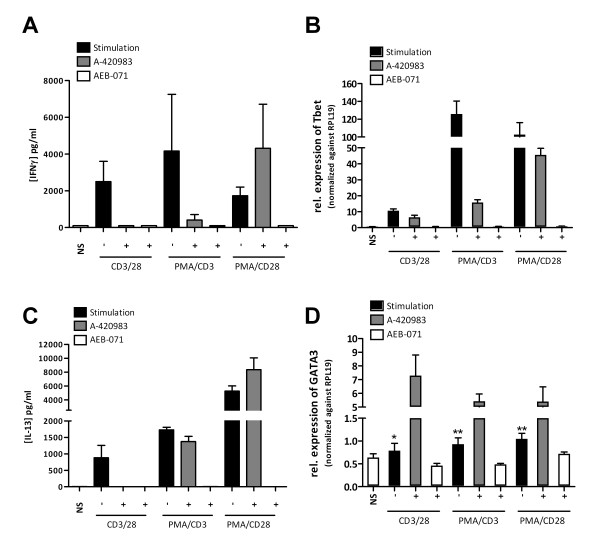
PMA/CD3 and PMA/CD28 effects on purified primary human CD4+ T cells. Purified CD4+ T cells were stimulated with anti-CD3/CD28, PMA/CD3 and PMA/CD28 and cultured for 24 hours in the presence or absence of pathway inhibitors for Lck (A420983; 1 μM) and PKC(AEB071; 1 μM). Culture supernatants were analyzed for IFNγ, production (A), mRNA expression of the Th1 master transcription factor T-bet (B), the production of the Th2 cytokine IL-13 (C) and expression of the Th2 master transcription factor GATA3 (D). Message RNA expression was normalized against ribosomal house hold gene RPL19. Data are presented of three independent experiments using purified human CD4+ T cells from three different healthy donors. Data are presented as mean + SD. Significance of differences are indicated by ** p < 0.01, * p < 0.05, using a mann-withney U-test.